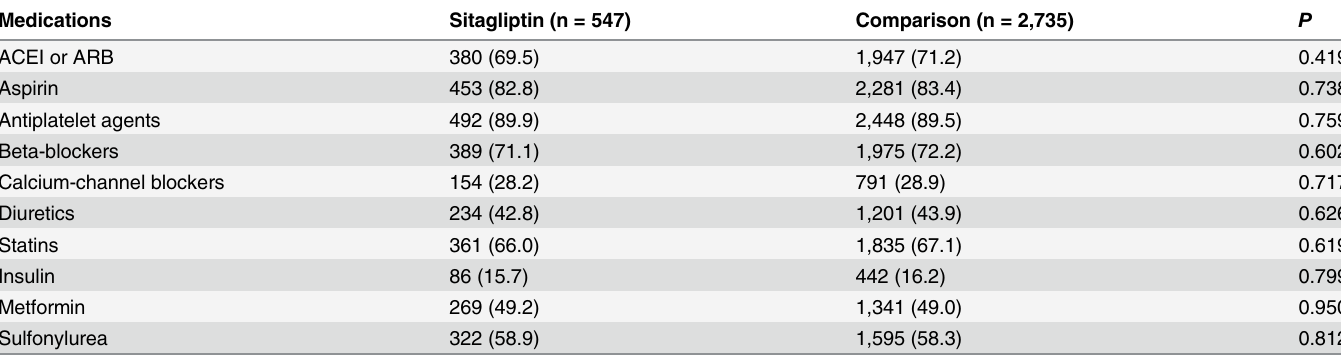
Table 2. Concomitant medications use within 90 days of index